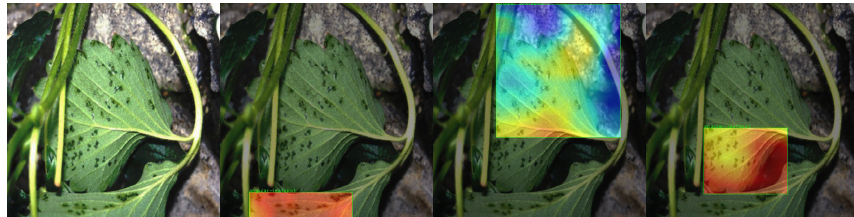
Figure 22. Grad-CAM test on Angular Leafspot sample.